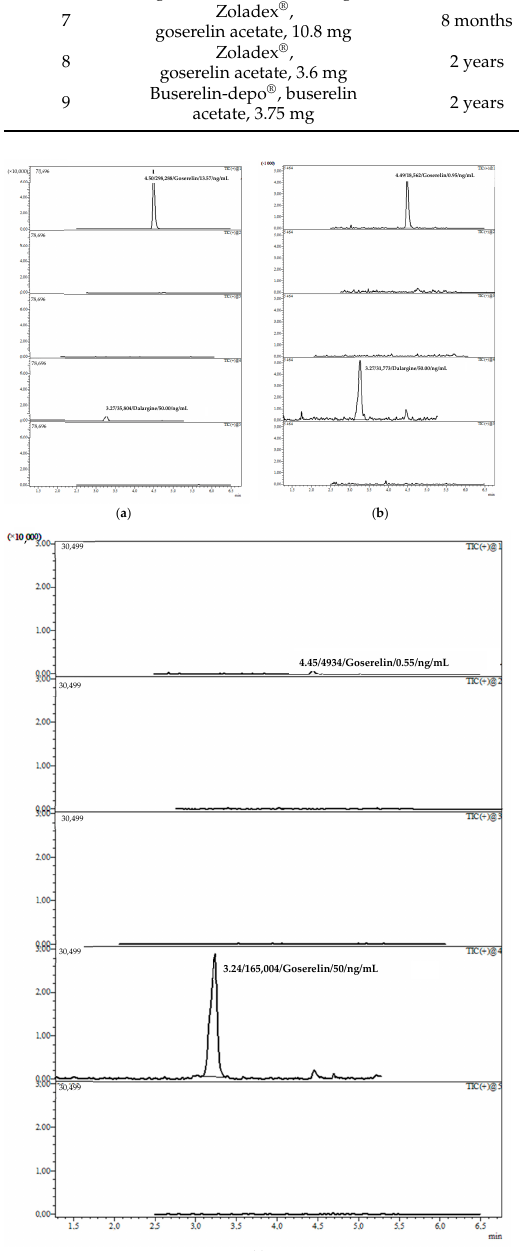
Figure 2. Representative chromatograms of the patient’s plasma sample for ( a ) patient No. 1; ( b ) patient No. 2, and ( c ) patient No. 3.